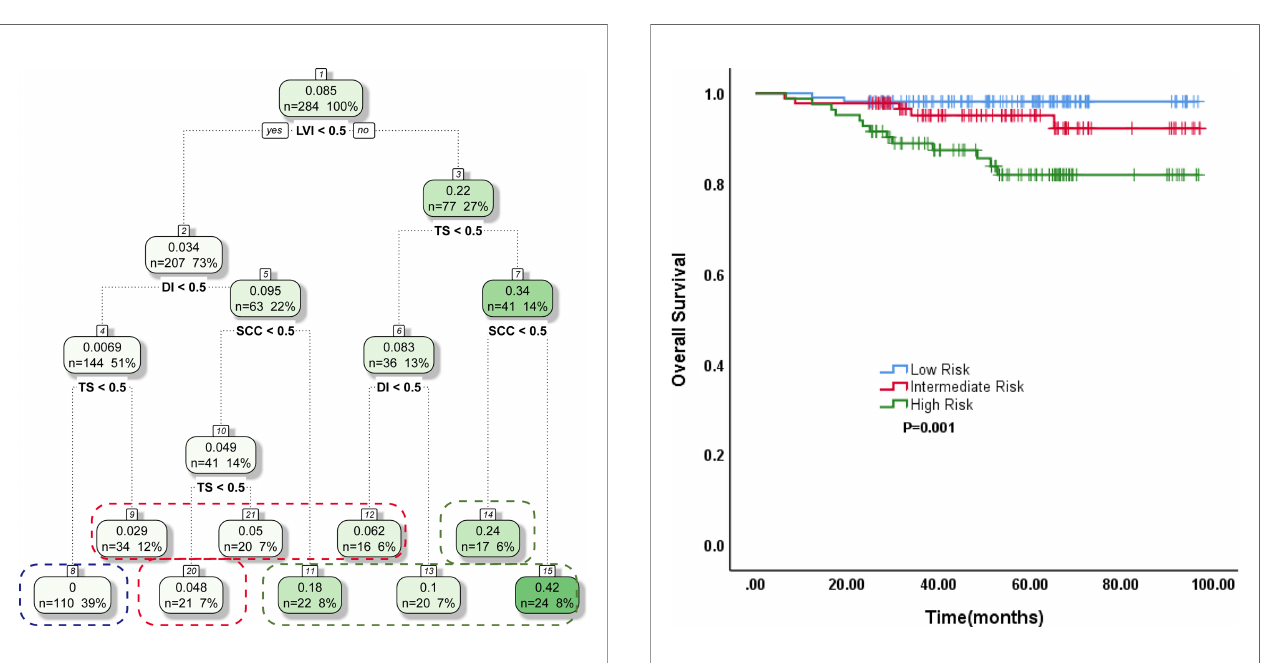
FIGURE 2 | Classi fi cation Tree for LNM Status. Blue line, Red line, Green line represents Low-Risk Group, Intermediate-Risk Group and High-Risk Group, respectively.